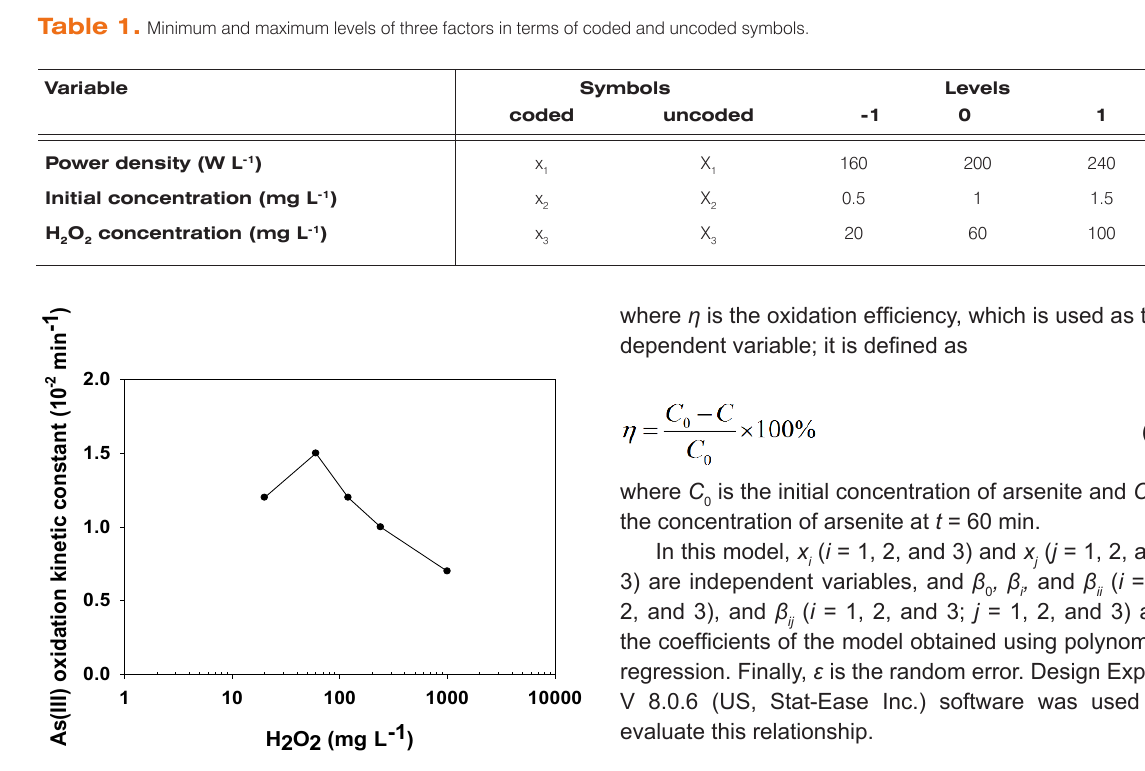
Figure 2. Pretest for the determination of the H range. The ultrasound power density was 160 W L -1 , and the initial concentration of arsenite was 1 mg L -1 .